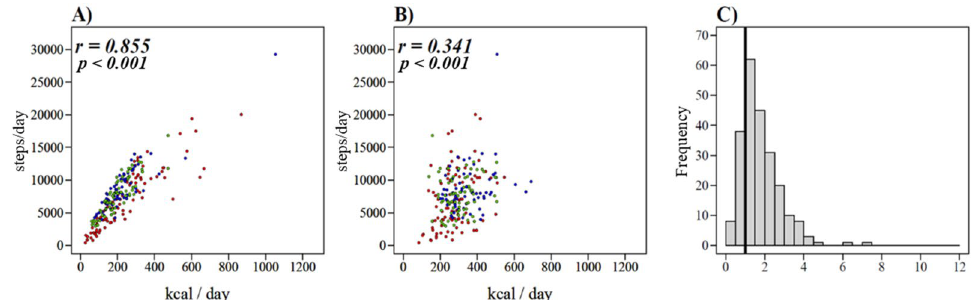
Figure 3. Scatterplots depicting the relationship between energy expenditure (EE) and step counts of the total sample and ratio of “Locomotive” and “Household” EE. ( A) “Locomotive” EE and step counts, ( B) “Household” EE and step counts, ( C) histogram of the ratio of “Household” EE to “Locomotive” EE. (The vertical line ( x = 1) means that the EE of “Locomotive” activities and “Household” activities in a day are equal). (cid:1749) : Student group; (cid:1749) : Standing worker group; (cid:1749) : Sitting worker group.